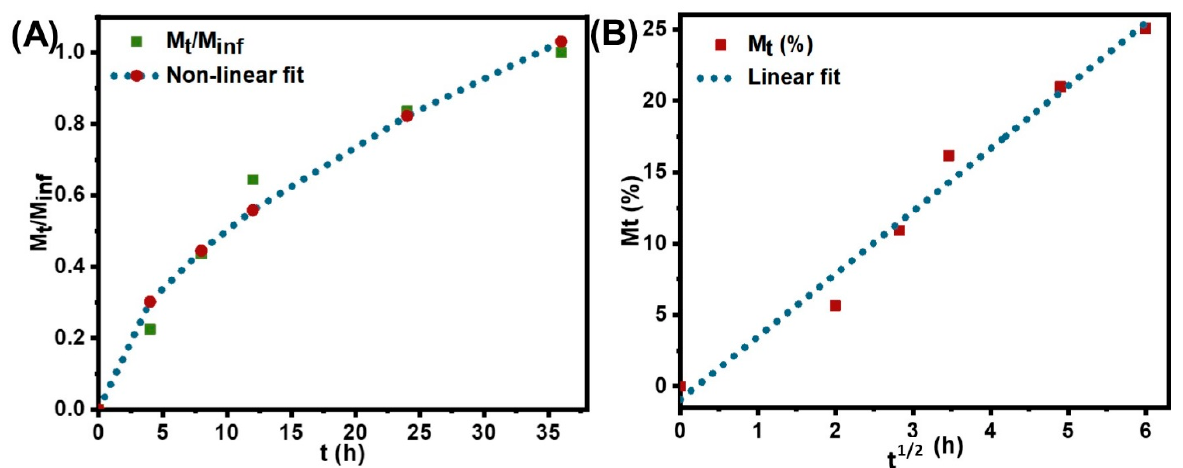
Figure 5. Fitting of cumulative % drug release data to ( A ) Ritger–Peppas and ( B ) Higuchi model for pH 5.